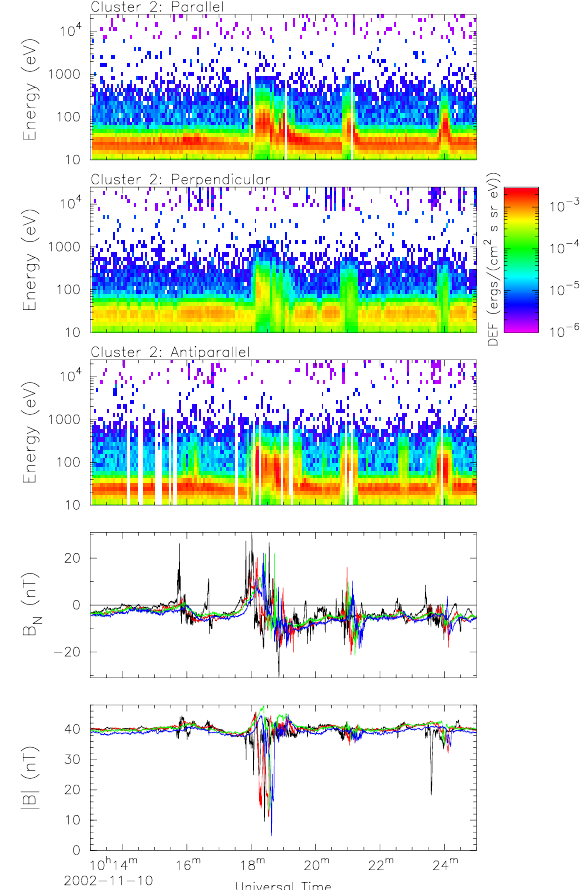
Fig. 13. PEACE electron data from Cluster 2 for FTE 1 (10 Novem- ber 2002, 10:18 UT). The figure adopts the same format as Fig. 10a. The PEACE instruments observed bidirectional accelerated magne- tosheath signatures, possibly due to pitch angle scattering as a result of variations in the magnetic field within the FTE. There are several other FTEs in this plot (e.g. 10:16, 10:17, 10:21, 10:24 UT), which either did not fulfil the criterion for inclusion in the survey carried out by Fear et al. (2005b), or which did not exhibit a clear enough bipolar B N signature on all four spacecraft for multi-spacecraft tim- ing analysis to be